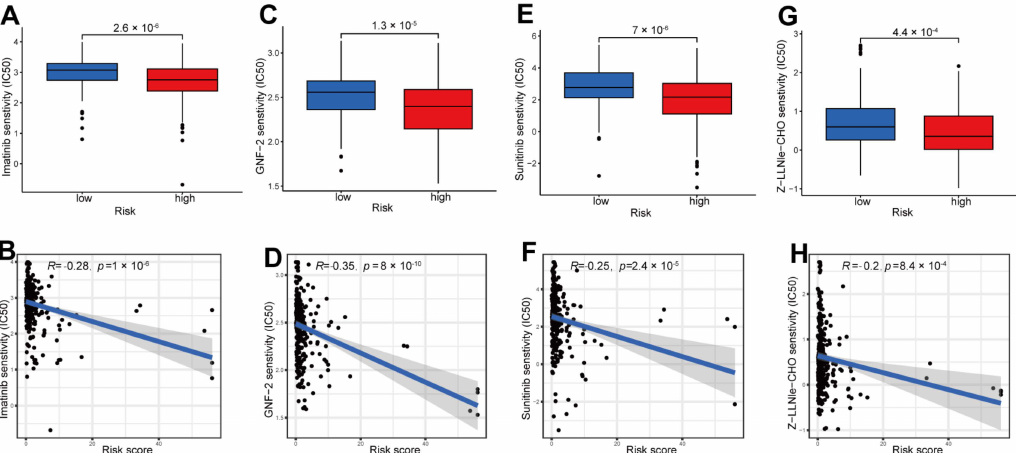
Figure 9. Identifying potential drugs for the treatment of pRCC. IC50 differences between high- and low-risk sets for four drugs: imatinib ( A , B ), GNF-2 ( C , D ), sunitinib ( E , F ) and Z-LLNIe-CHO ( G , H ).